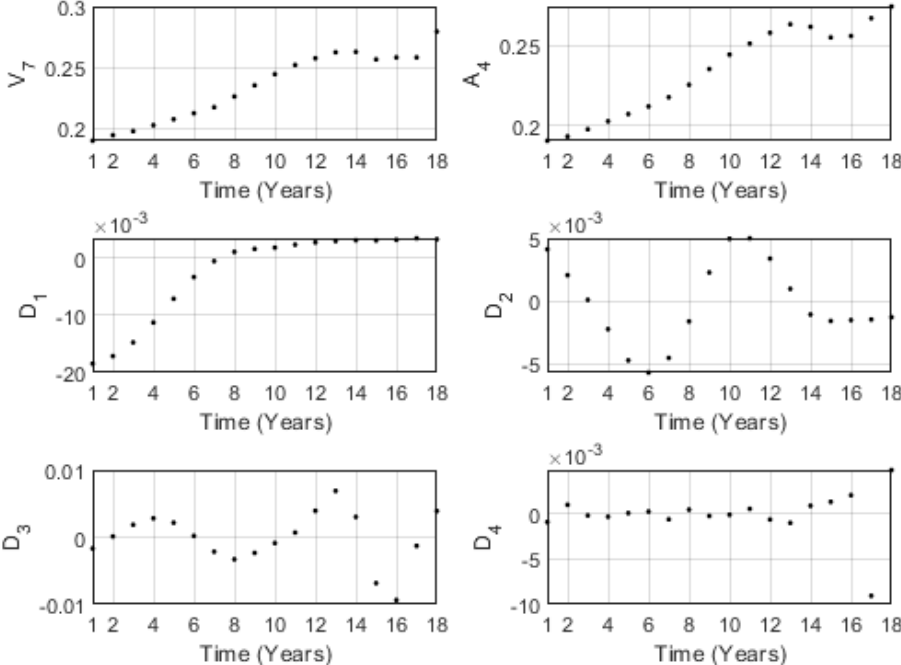
Figure 7. The wavelet decomposition of the variable V 7 at the level